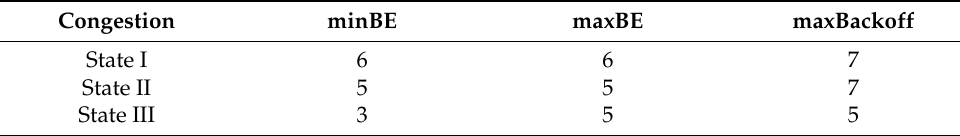
Table 3. Proposed values for the CSMA-CA